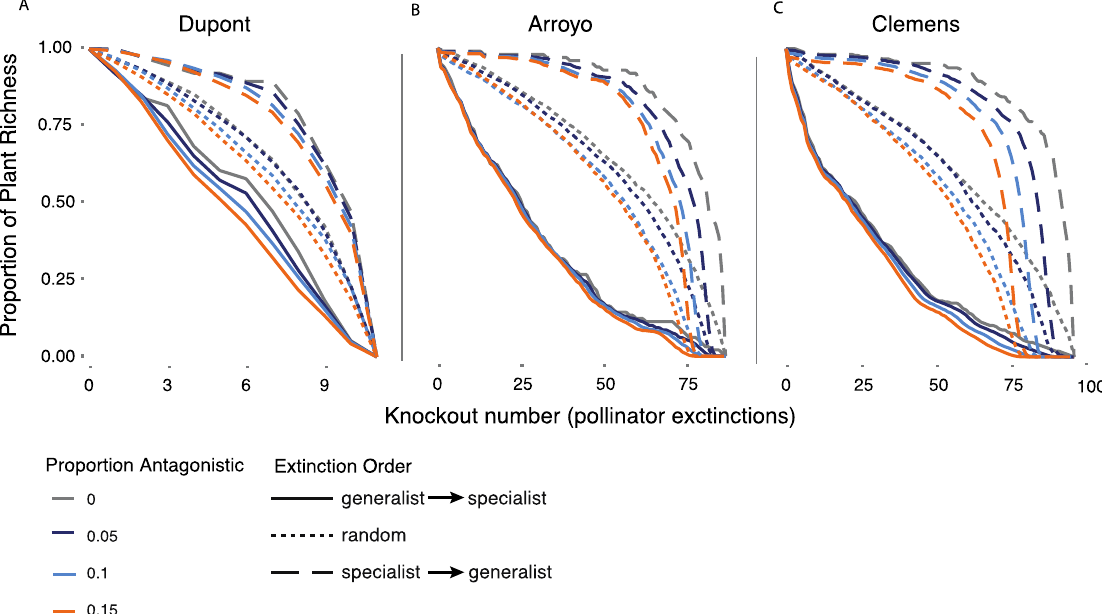
F IGURE 1: Extinction patterns for the three pollination networks (A) Dupont, (B) Arroyo and (C) Clemens. For a given treatment, we tracked the dynamics of plant extinctions following simulated pollinator knockouts. X axis for each network is constrained by the total number of pollinators in that given network. Lines represent the mean of 50 simulations for each given proportion negative and extinction